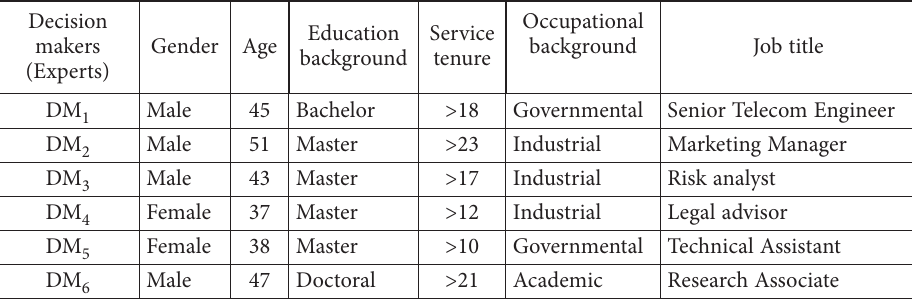
Table 1. Demographic characteristics of the expert decision makers